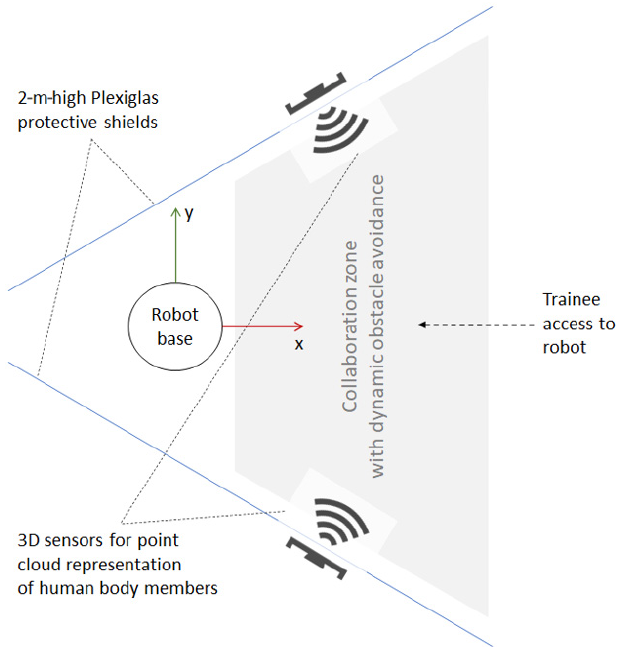
Figure 11. Edubot scenario: Proposed layout for the training robot station.